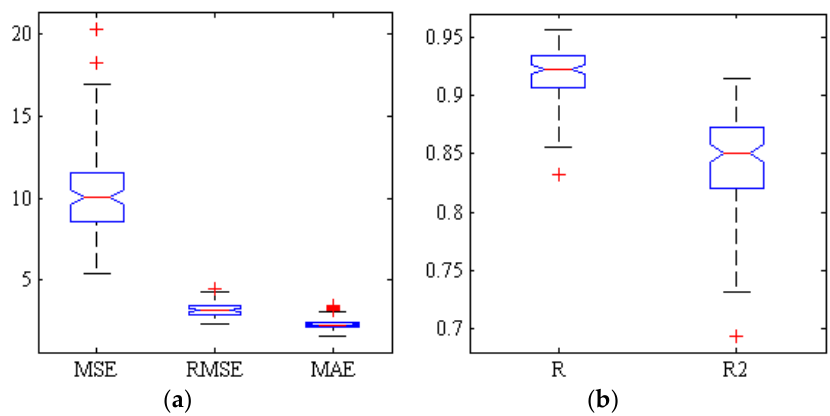
Figure 4. Correlation analysis of scatter plot between mean estimated and measured taste index of Gala cultivar using ANN-PSO algorithm based on spectral data related to key wavelengths in 300 iterations.